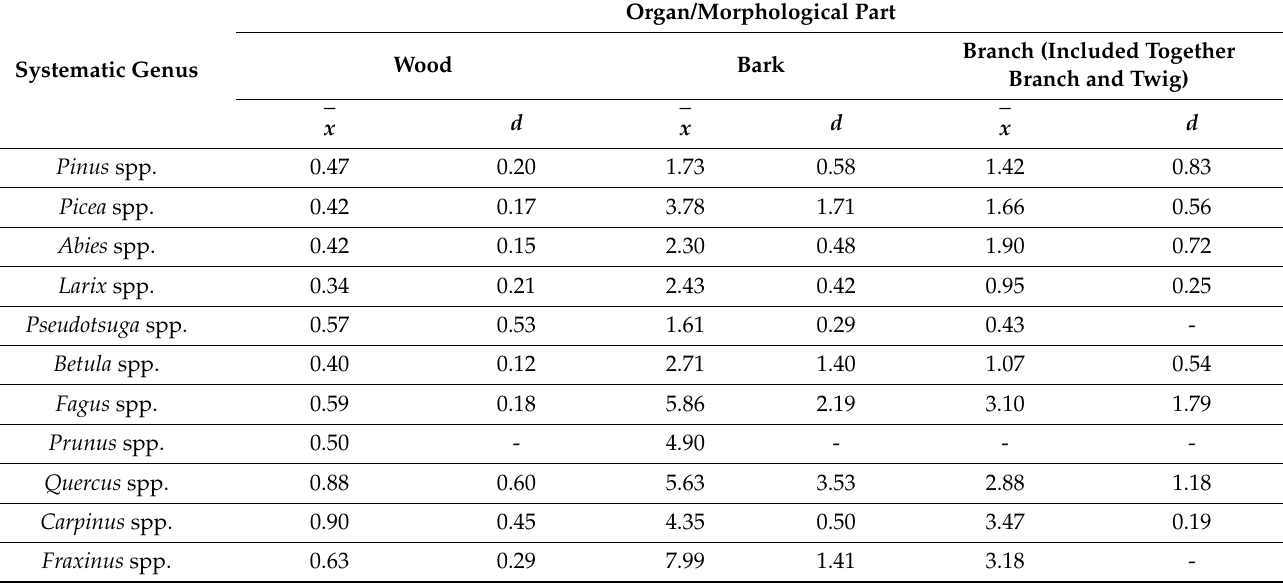
Table A13. Average value and average deviation of the ash content (% d.m.) in various organs of particular systematic genera